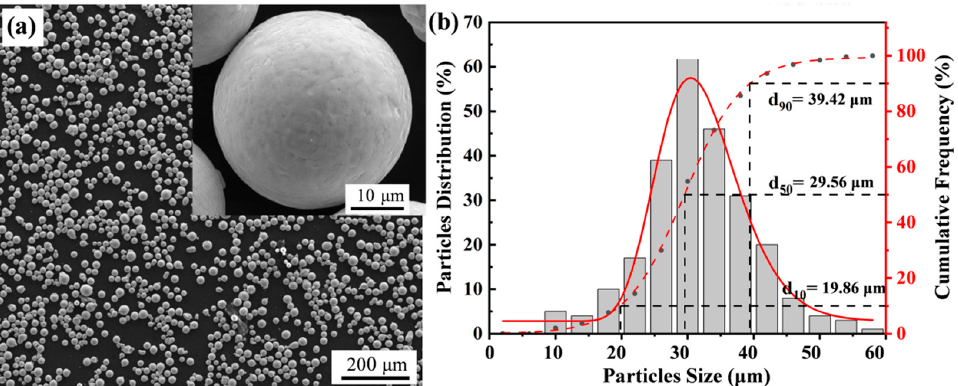
Table 1. Chemical composition (Wt. %) of the Inconel 718 powder.